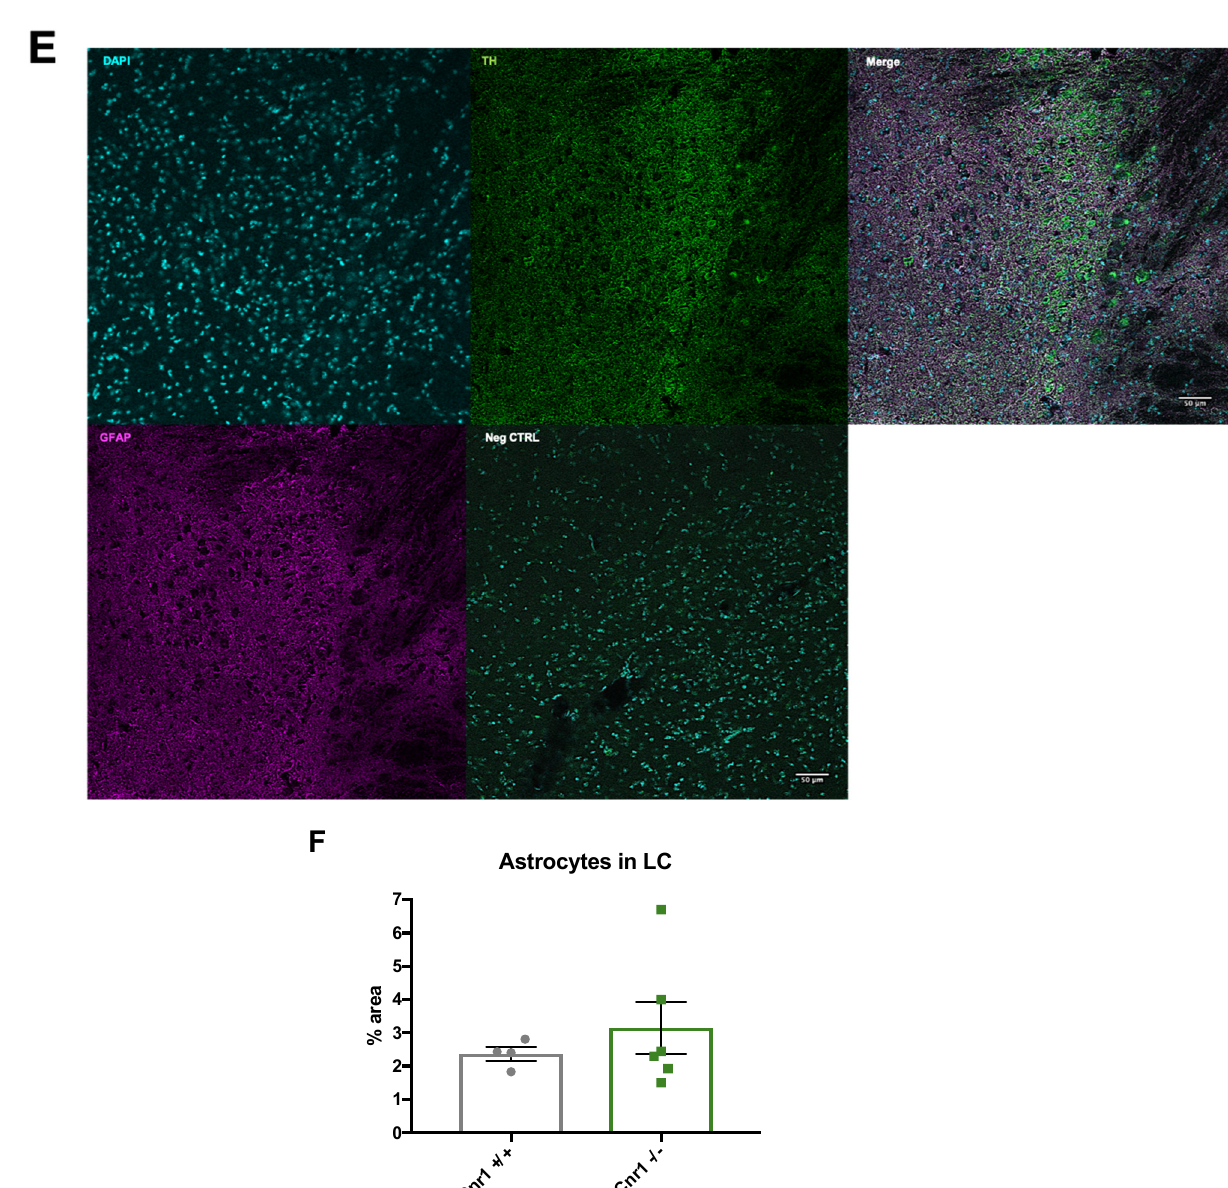
Figure 6. ( A ) Representative photomicrograph of tumor necrosis factor (TNF α ), tyrosine hydroxylase (TH) and ionized calcium-binding adapter molecule 1 (Iba1) staining within the LC of an 18-month-old wild-type animal. Negative controls (Neg CTRL) were stained only with the secondary antibodies. Scalebar: 50 µ M. ( B ) Density of Iba1-positive microglia within the LC. * p < 0.05 according to Student ´ s t -test ( n = 5–8 per genotype). Dots represent single animals, columns represent mean values, error bars represent standard error of means (SEM). ( C ) Analysis of TNF α and ( D ) Iba1 signal intensity in microglia cells within the LC. Dots represent individual values ( n = 224–291 per genotype). ( E ). Representative photomicrographs of glial fibrillary acidic protein (GFAP) and tyrosine hydroxylase (TH) staining in the LC of an 18-month-old wild-type mouse. Negative controls (Neg CTRL) were stained only with the secondary antibodies. Scalebar: 50 µ M. ( F ) Percentage of area covered by GFAP signal within LC ( n = 4–6 per genotype). Dots represent single animals, columns represent mean values, error bars represent standard error of means (SEM).